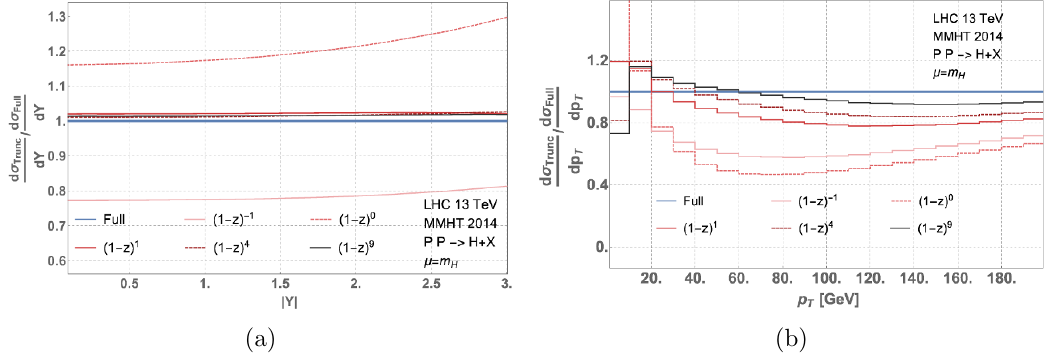
Figure 3. NNLO absolute rapidity (left) and transverse momentum (right) distribution for the Higgs boson. The blue line represents the exact result. Increasingly darker shades of red represent higher and higher truncation order of the threshold expansion. All lines are normalized to the exact NNLO